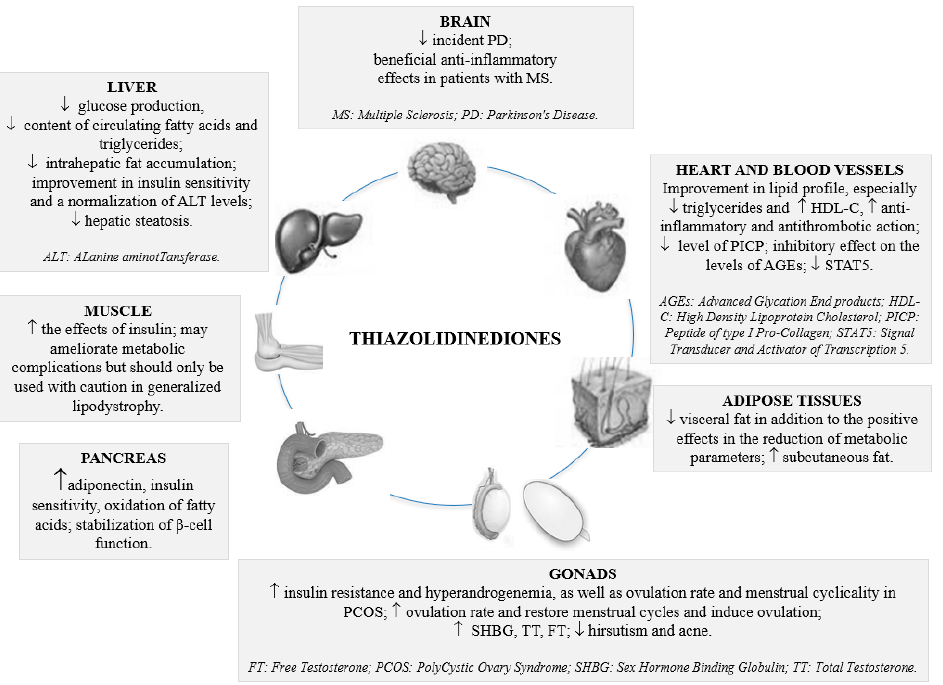
Figure 1. Pleiotropic effects of thiazolidinediones.